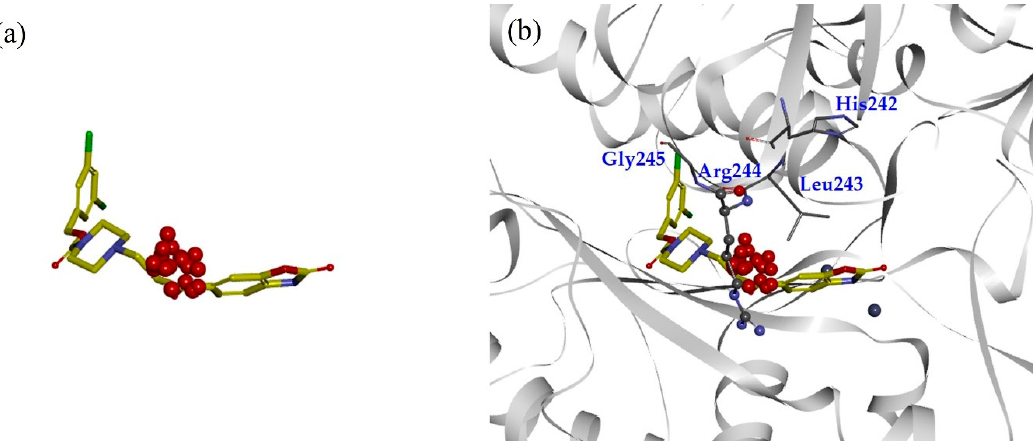
Figure 2. ( a ) Structure of PF-8380 overlapped with topological water networks (TWNs) of the L’ region. ( b ) Overlay of ligand and TWNs in the ATX binding site. Centers of mass of water networks are represented by red spheres while PF-8380 is displayed by gray stick model. Binding site residues His242, Leu243 and Gly245 are represented by gray thick line model, whereas the Arg244 that exists adjacent to the L’ region is shown by ball and stick model.